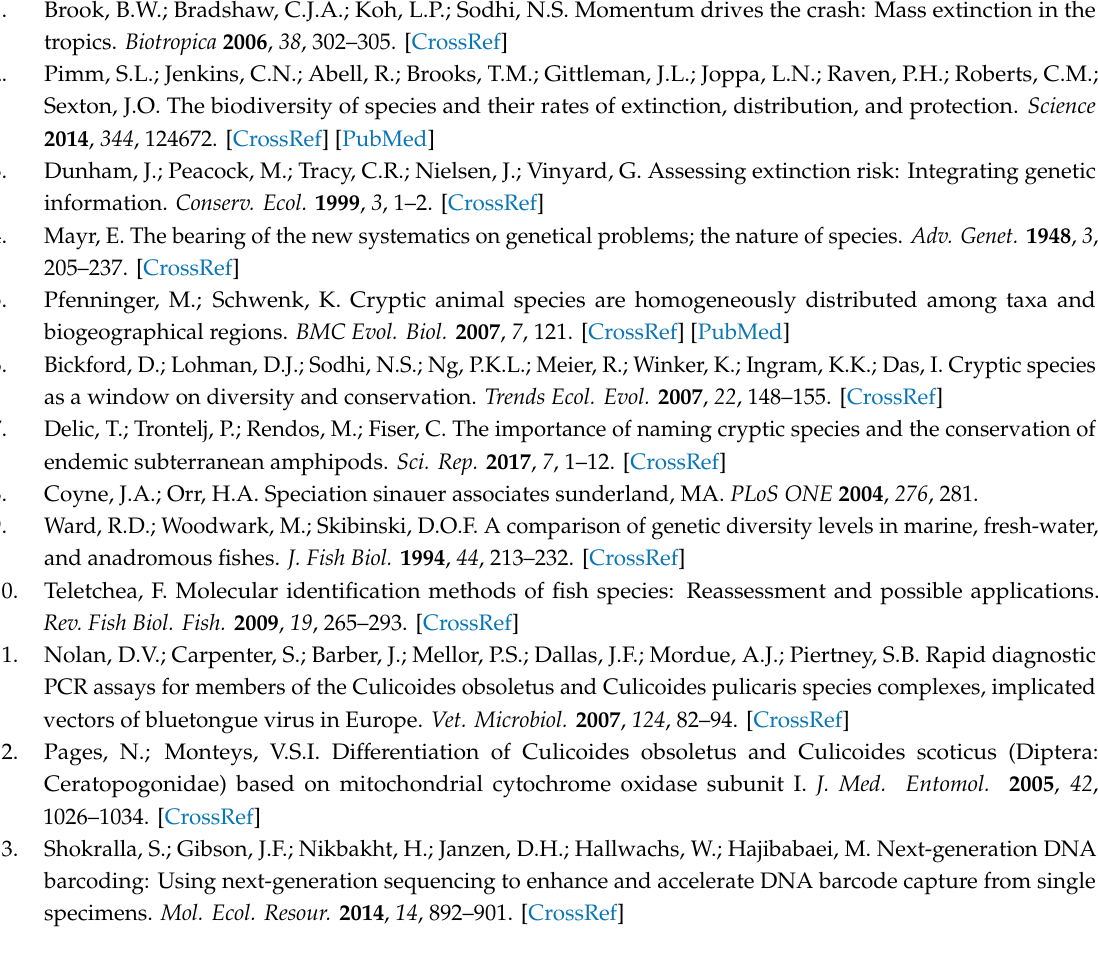
Supplementary Materials: The following are available online, Table S1: Details of the detected peaks and results of statistical analyses. Table S2: Result reports of Mass-Up software analyses. Figures S1 and S2: Principal Component Analysis plots of MALDI-TOF MS spectral datasets derived from gudgeon brain and muscle tissues, Figure S3: representative mass spectra of brain and muscle